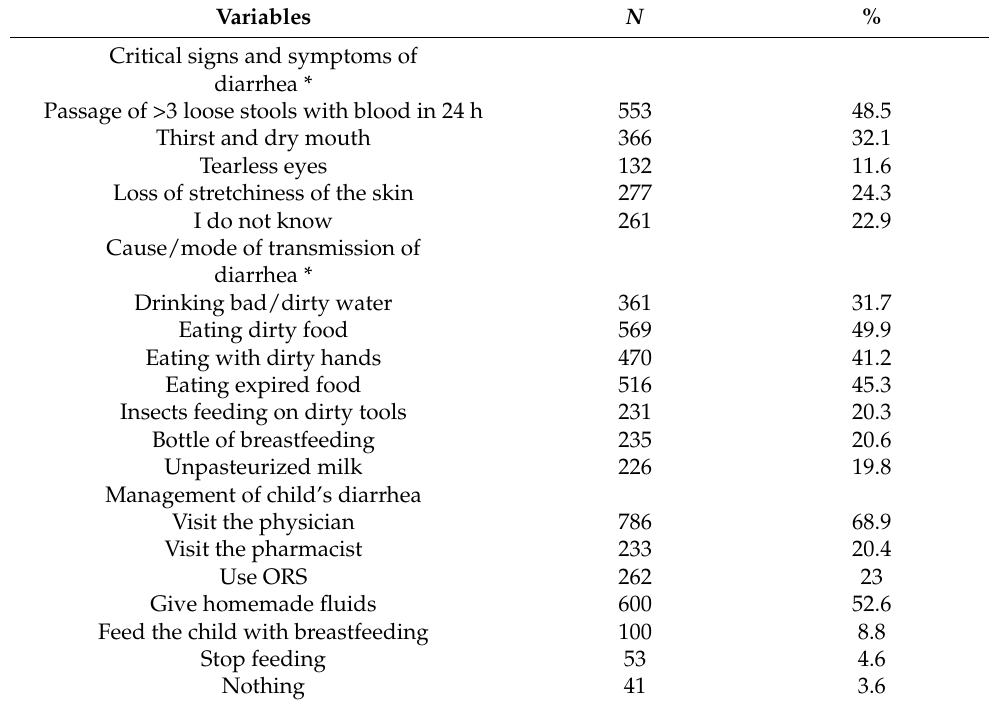
Table 2. Mothers’ knowledge about diarrhea and its